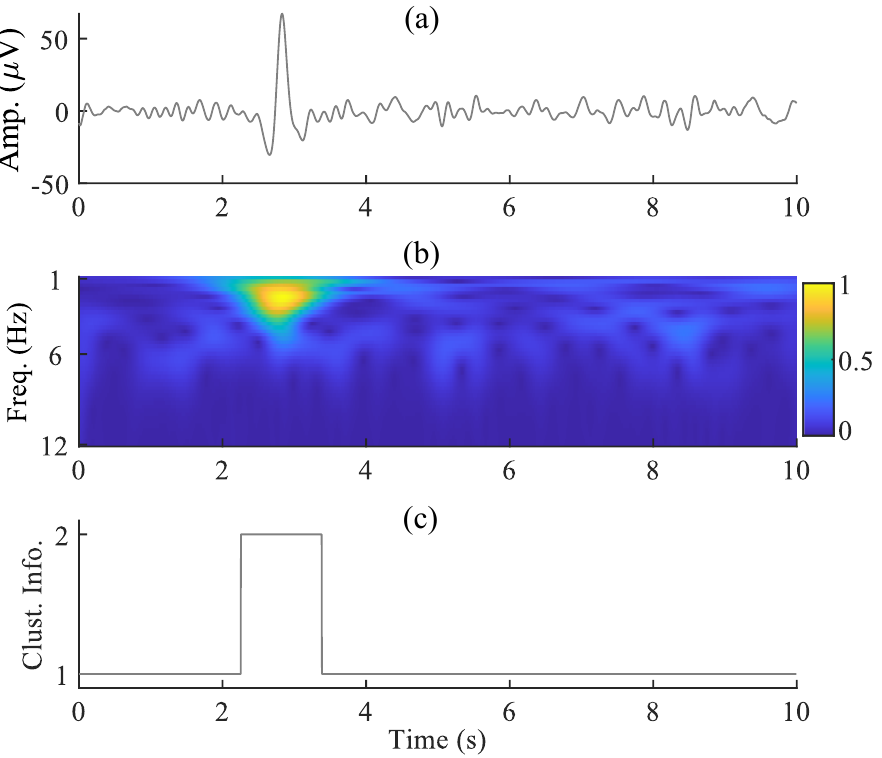
Figure 4. ( a ) The extracted eye-blink artifact (¯ a ) by SSA, ( b ) its time–frequency representation using CWT (normalized plot) and ( c ) clustering